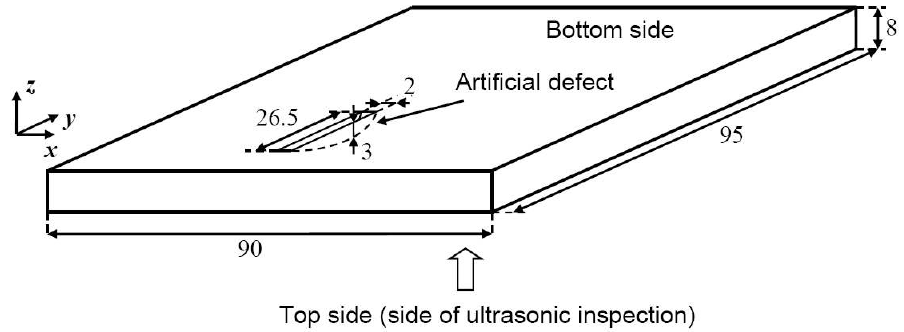
Figure 3. The setup of the investigated aluminium sample possessing artificial crescent-shaped defect (all dimensions are provided in mm, view from the bottom side).